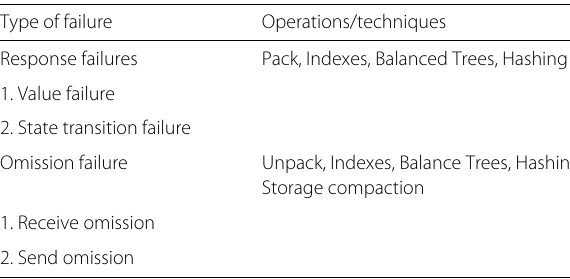
Table 1 Failure models Type of